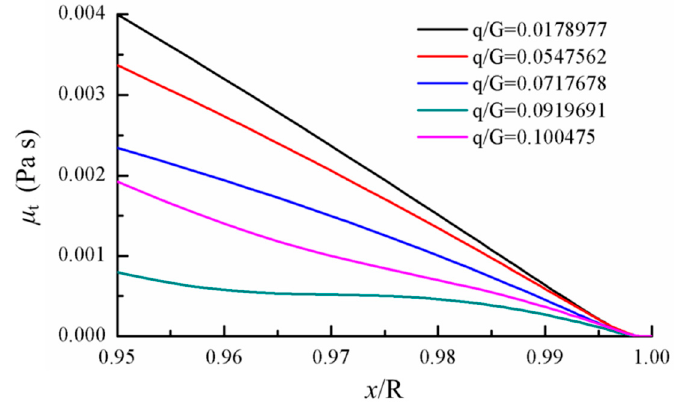
Figure 22. Distribution of the turbulent viscosity ( x/D = 39).